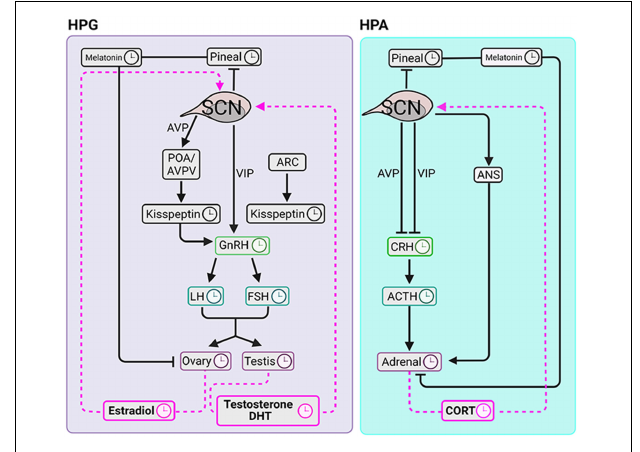
FIGURE 3 | Circadian clocks of the HPG and HPA axes. The SCN coordinates diurnal fluctuations in the HPG (left panel) and HPA (right panel) axes thereby impacting steroidogenesis. The signals to the gonads travel via the hypothalamus-pituitary-axis and via pineal melatonin. SCN signals to the adrenal glands course via hypothalamus-pituitary-axis, pineal melatonin and via autonomic nervous system. Symbols: clockfaces indicate sites that express daily rhythms. Black lines are pathways from the SCN to the downstream elements. Pink dashed lines indicate signaling pathways from circulating glandular steroids to the